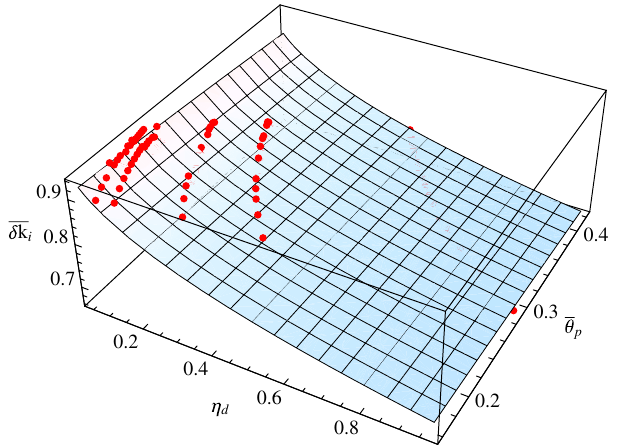
FIG. 7. Relative difference between the analytic and simulated ¼ 0 : 5 fits for (cid:5) d